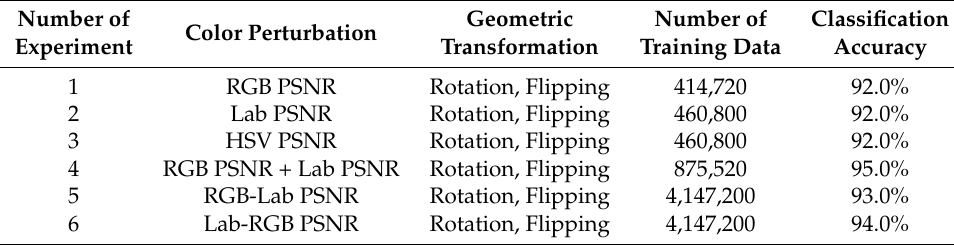
Table 7. Classification accuracy obtained upon applying the inverse PSNR method and two geometric transformations.